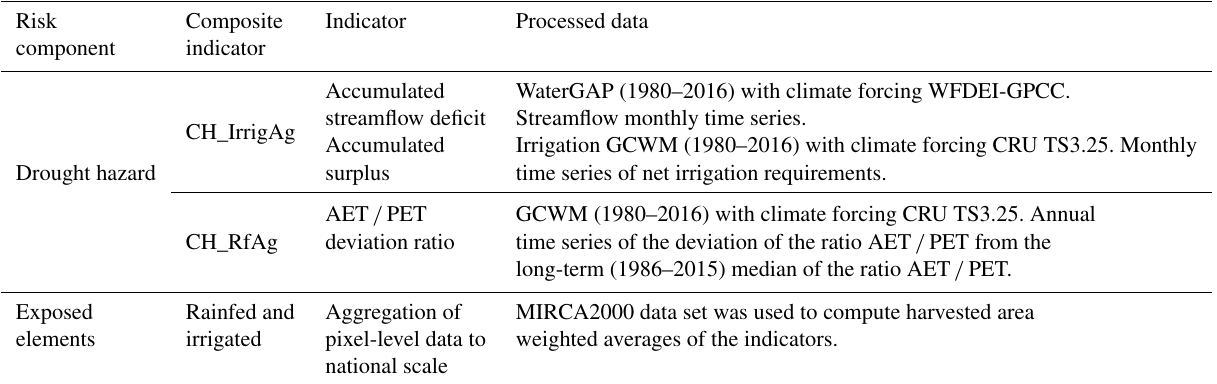
Table 1. Hazard and exposure indicators used in the analysis and their processed data. Risk Composite